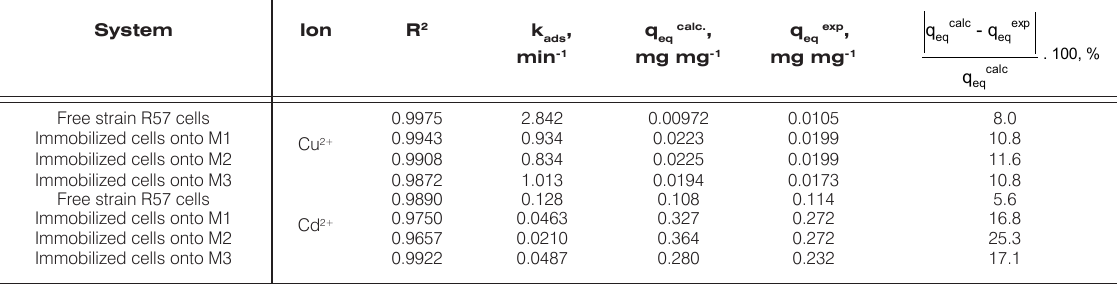
Table 1. Second order kinetic model